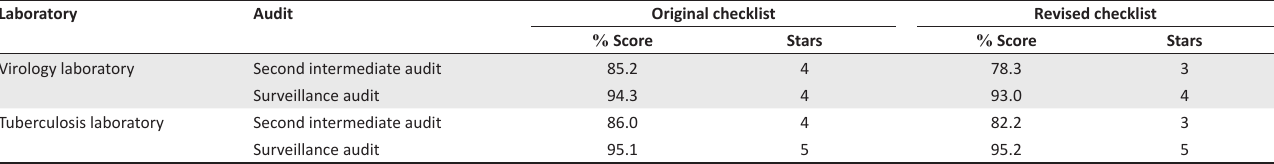
TABLE 2: Comparison of audit scores based on the original 2009 WHO AFRO checklist and the revised 2012 checklist.